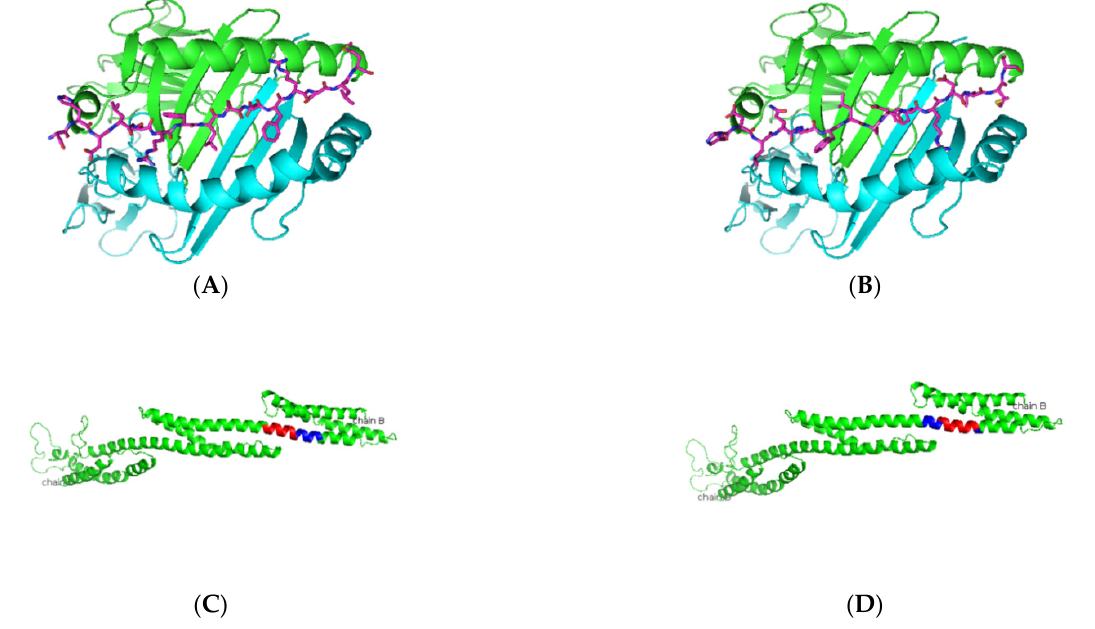
Figure 5. Predicted α -fodrin peptide binders docked on HLA-DRB1*0103. ( A , B ) Based on the prediction by SMM-align using IEDB, the top two peptides with IC50 values of 12 were docked onto the crystal structure of HLA-DRB1*0103 PDB structure 1A6A, and the most optimum predicted position of docking is indicated for both peptides SHDLQRFLSDFRDLM and HDLQRFLSDFRDLMS with the core sequence of SHDLQRFLS and FLSDFRDLM, respectively. ( C , D ) The highlighted region indicates the presence of the peptides in the three-dimensional structure of the α -fodrin protein.